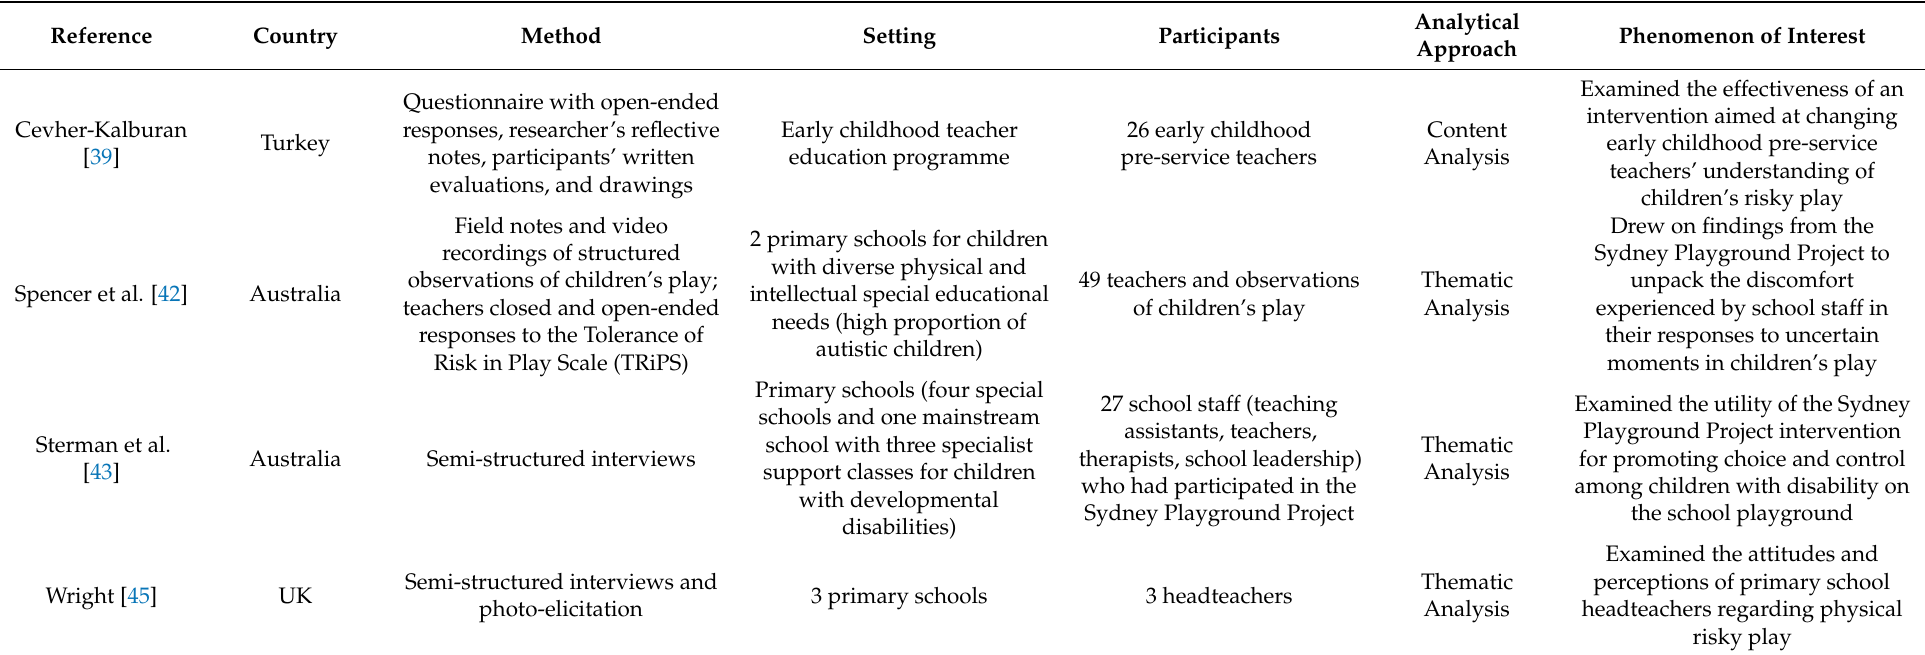
Table 2. Study characteristics of included articles, meta-aggregative